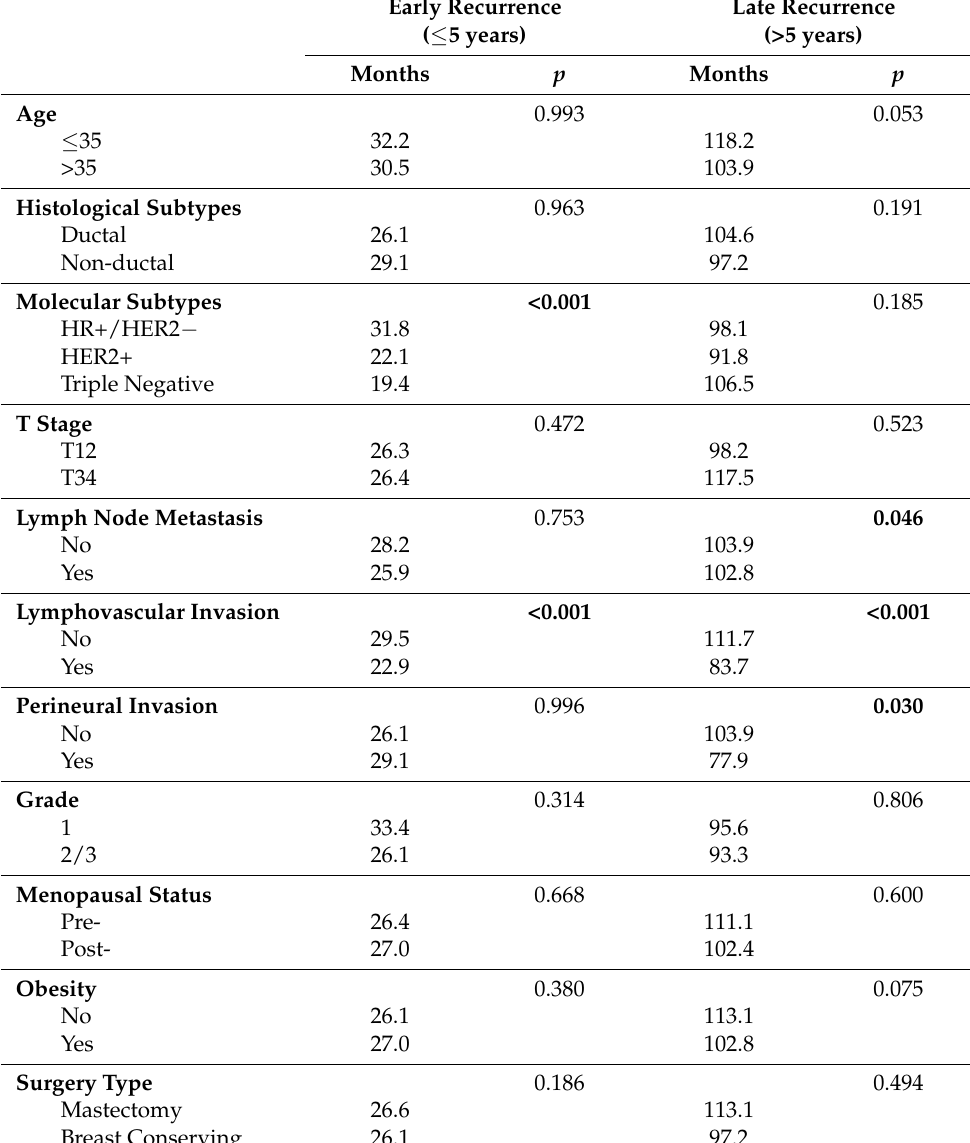
Table 4. Univariate analysis of disease-free